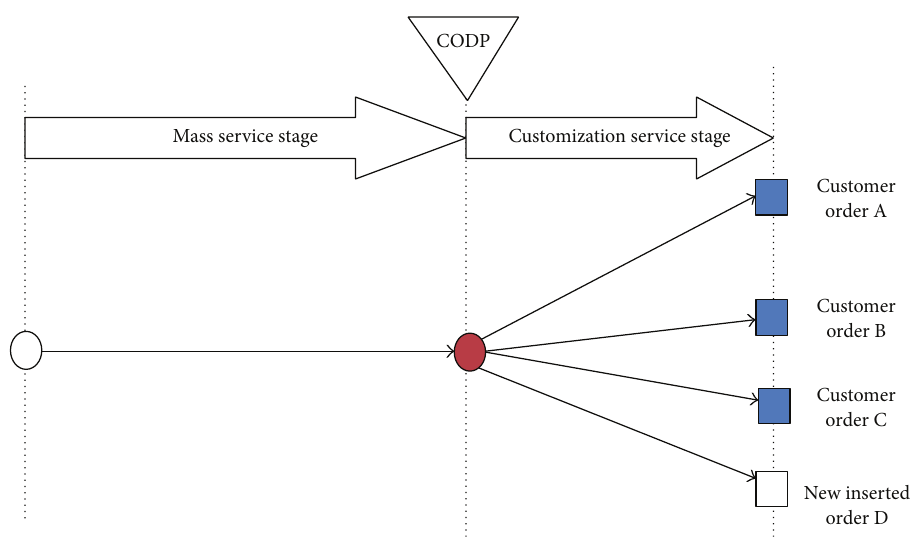
Figure 2: Customer orders’ operation processes schematic diagram of LSSC which is simplified.